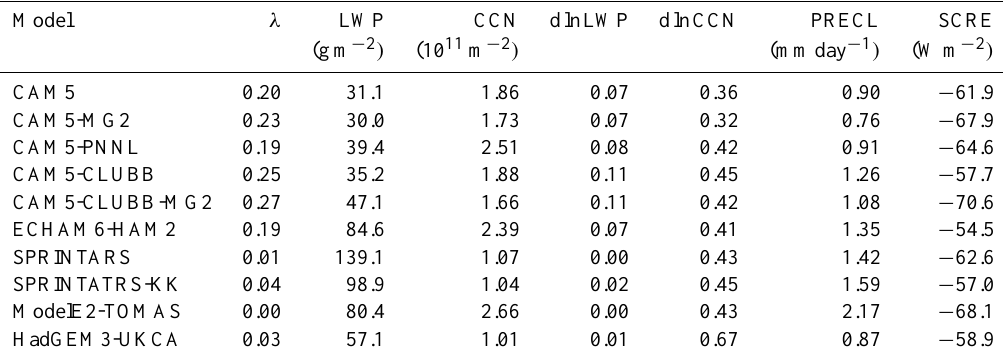
Table 2. Global ocean (60 ◦ S–60 ◦ N) averages of LWP, column-integrated cloud condensation nuclei (CCN, at 0.1% supersaturation) con- centration, precipitation rate (PRECL), shortwave cloud radiative effect (SCRE) derived from the present-day (PD) cases and the relative change from pre-industrial (PI) to PD of LWP and CCN (dlnLWP and dlnCCN) and the sensitivity of LWP to CCN concentration change ( λ , dlnLWP / dlnCCN) of the 10 GCM simulations. Model λ LWP